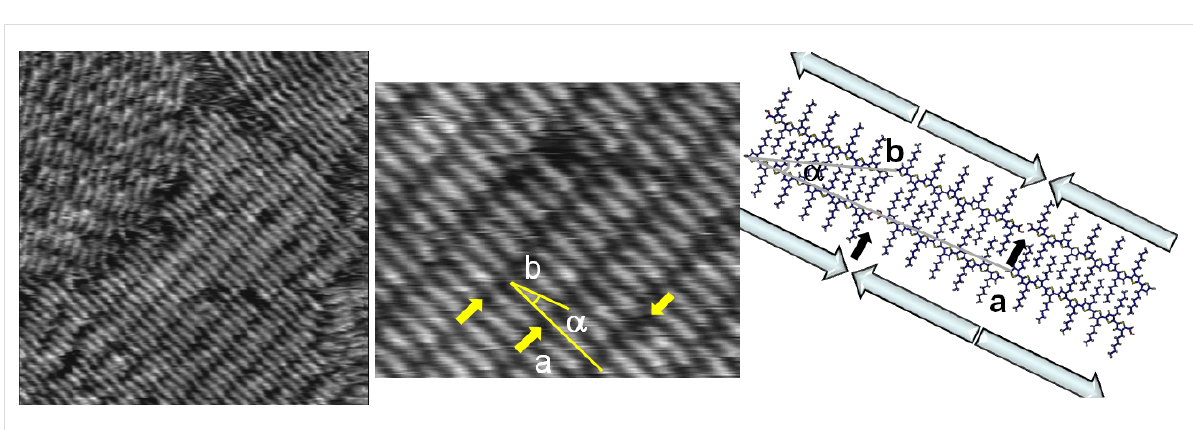
Figure 5: STM images of H10TCOOH . Left: 50 × 50 nm 2 , U = − 200 mV, I = 73 pA. Center: 24 × 19 nm 2 , U = − 100 mV, I = 22 pA. Right: Theoretical model. The small black arrows point out the H-bonding position. The big arrows show the orientation of the molecular dipole moments.